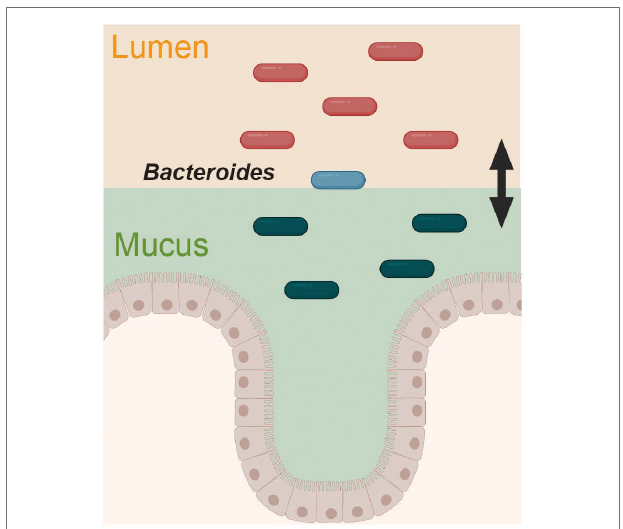
FIGURE 3 | Spatially distinct physiology of Bacteroides fragilis during colonization. The gene expression pattern in B. fragilis was distinct in the mucus layer and epithelium versus the intestinal lumen. This figure was adapted from Donaldson et al. (2020) and created using BioRender (https://